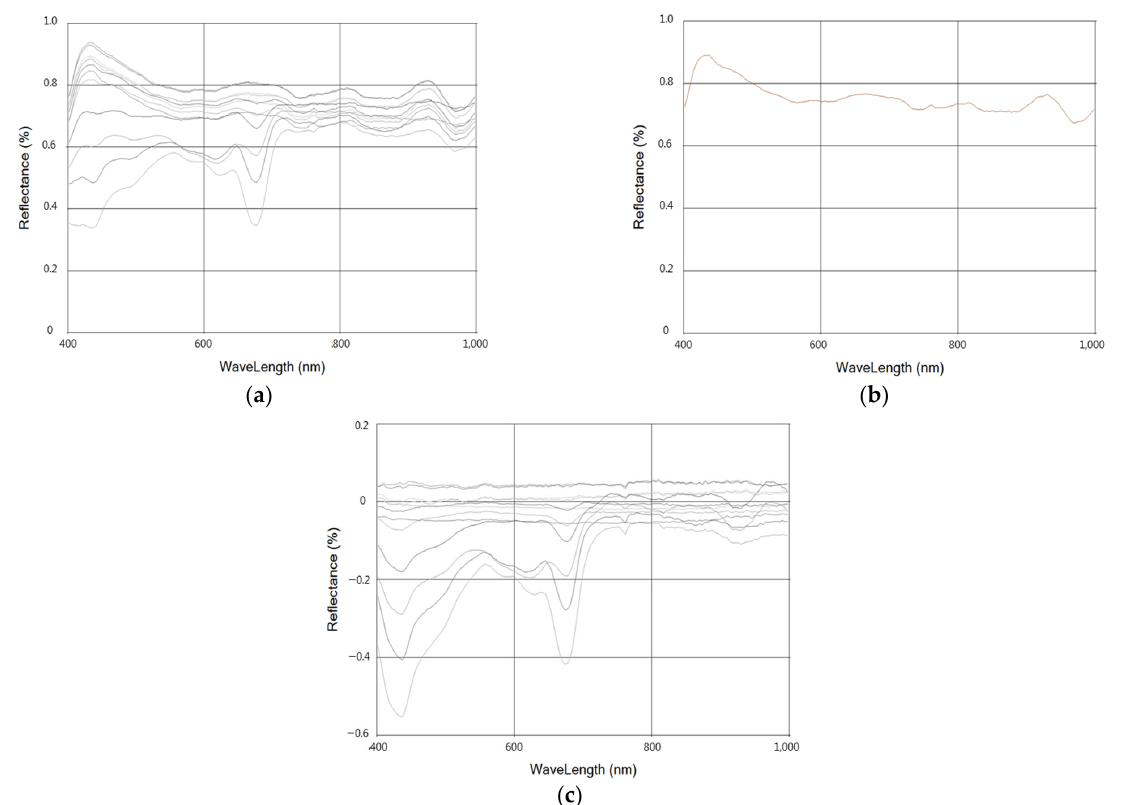
Figure 7. Algae spectral spectrum (( a ) algae spectrum—radiometrically calibrated algae spectra, ( b ) BG11 spectrum—radiometrically calibrated BG11 spectra, ( c ) algae spectrum—BG11 spectrum—resultant spectrum of algae with specific spectral features extracted by subtracting the radiometrically calibrated BG11 spectra from the radiometrically calibrated algae spectra).